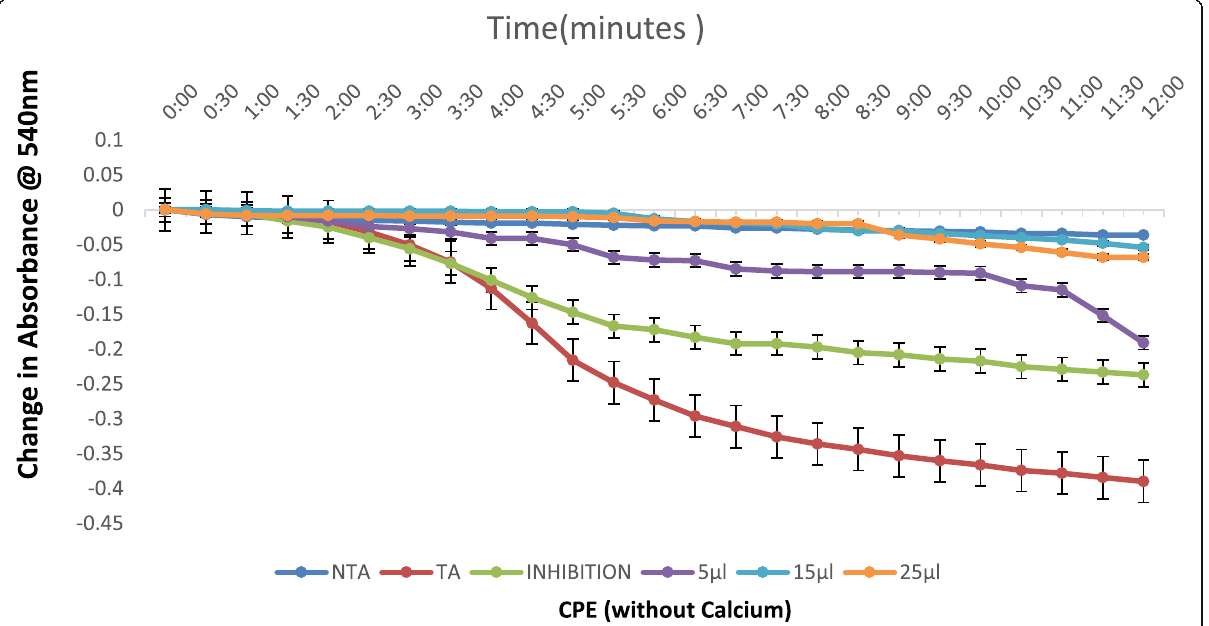
Fig. 3 Effect of varying concentrations (10 µg/ml, 30 µg/ml, and 50 µg/ml corresponding to 5, 15, and 25 µl) of crude ethanol extract of Cassava biogas slurry on rat liver mitochondrial membrane permeability transition pore in the absence of calcium (Ca 2+